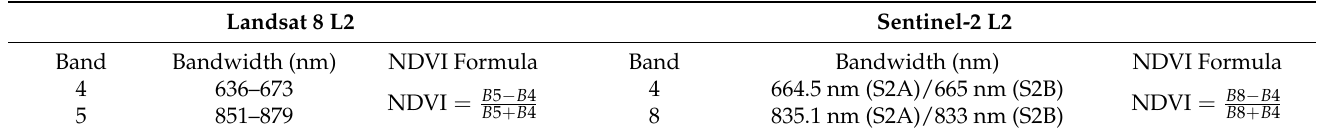
Table 2. NDVI calculation formulae for Landsat 8 L2 and Sentinel-2